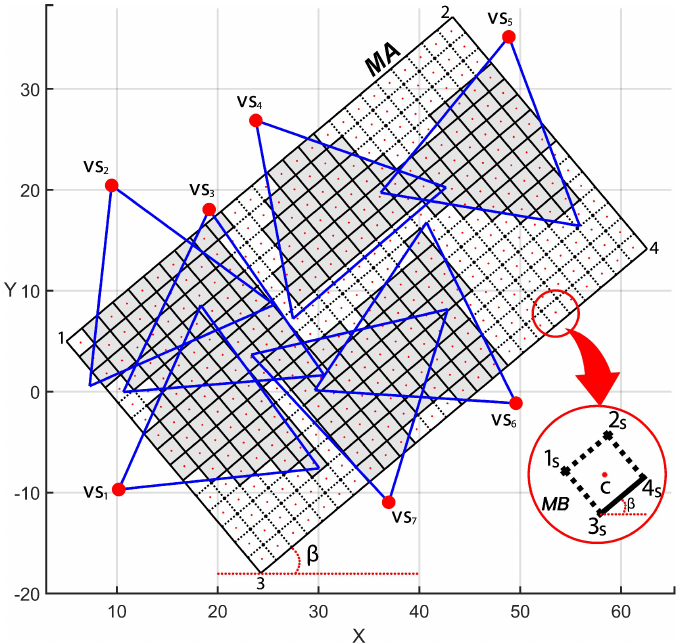
Figure 2. Monitoring area being covered by visual sensor nodes vs i , i = 1, . . . ,7